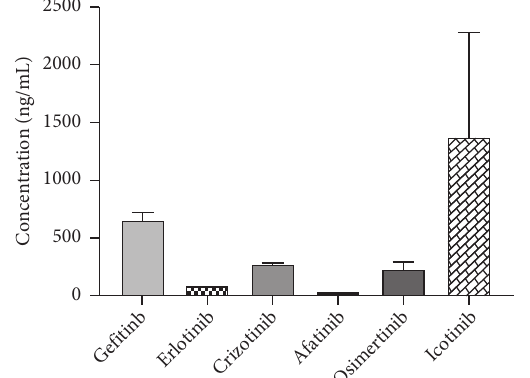
Figure 3: Drug concentration distribution of NSCLC patients with 25